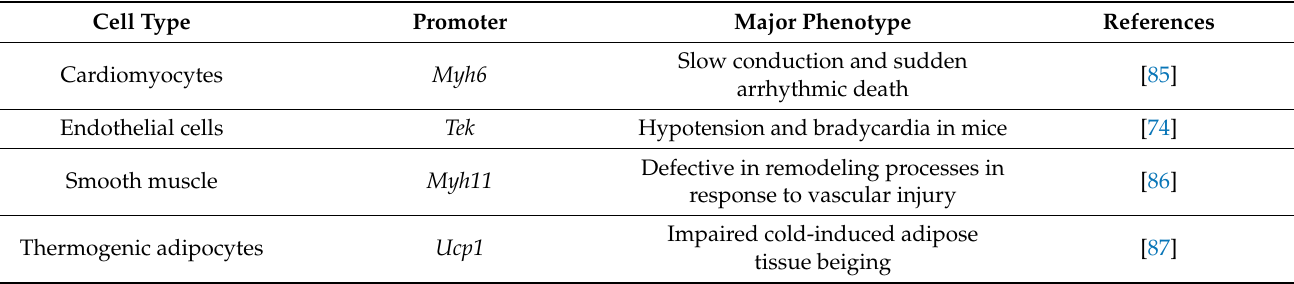
Table 1. The genetic manipulation of Cx43 in different cell types reveals its physiological functions in corresponding tissues. The “Cell Type” column shows in which cell type(s) Cx43 was deleted. The “Promoter” column shows which promoter was used to drive the CRE expression. The “Major Phenotype” column shows the most relevant phenotype in the corresponding mouse model, with references given in the “References”